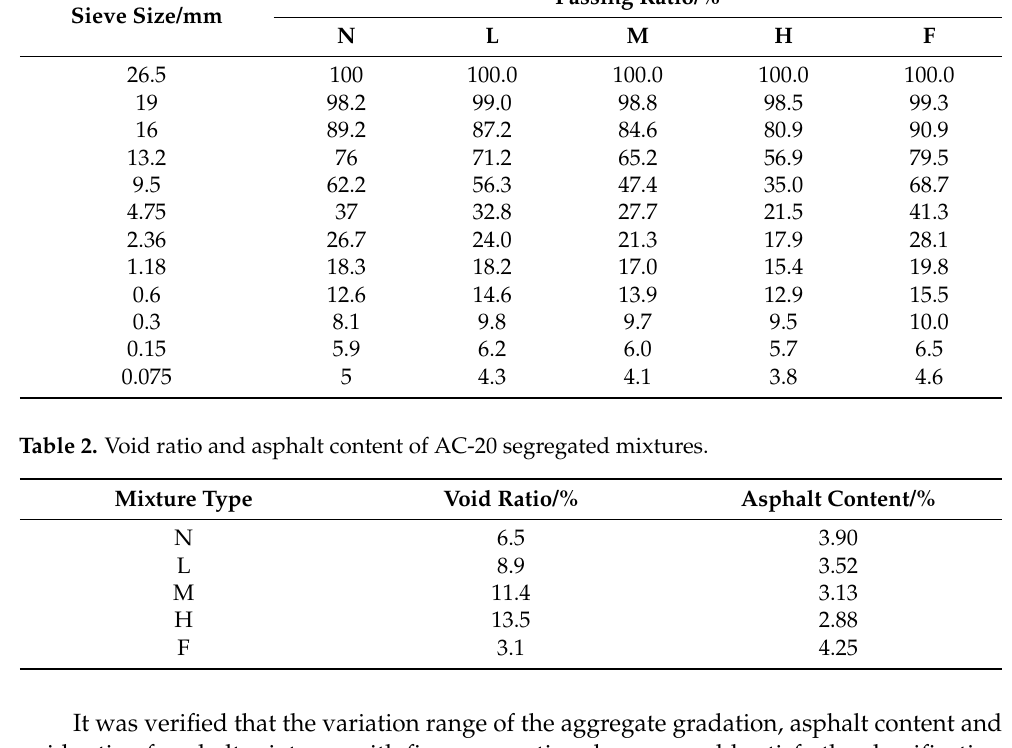
Figure 14. The calculated results of the horizontal heterogeneity coefficient of constituent components of asphalt mixtures in different CT images are shown in Table